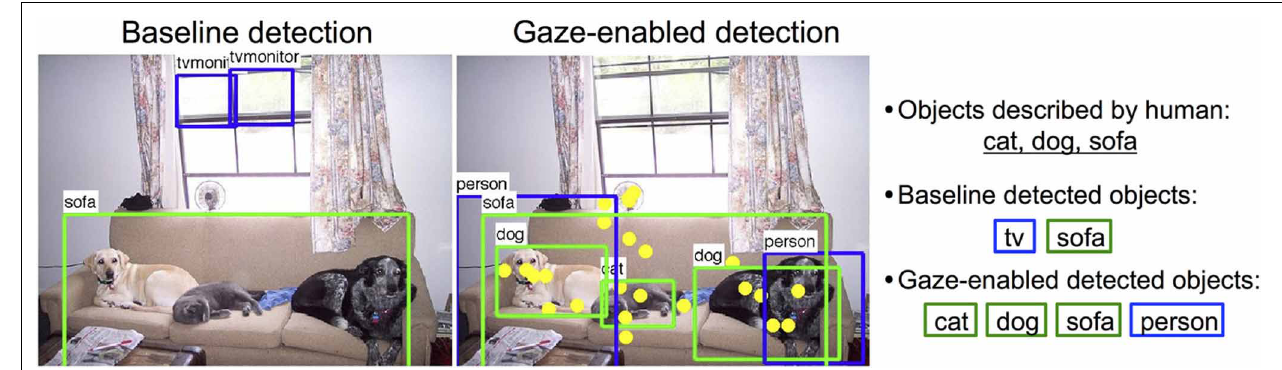
FIGURE 2 | Left: Baseline detection results using 20 deformable part models from Felzenszwalb et al. (2010) with default thresholds including correct detections (green) and incorrect detections (blue).